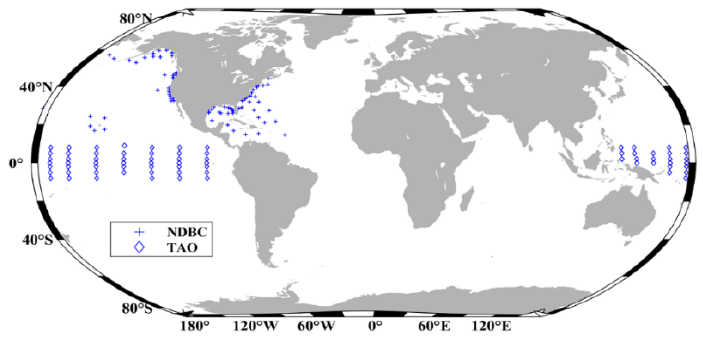
Figure 1. The locations of NDBC and TAO buoys. Buoy-measured wind speeds at different heights above the ocean surface are adjusted to the equivalent neutral winds at 10 m height, utilizing a simple logarithmic wind profile equation [19] where z 0 is the sea surface roughness length, with a constant value of 1.52 × 10 − 4 m assuming a drag coefficient of 1.3 × 10 − 3 [20], z is the reference height of 10 m, z H is the height of anemometer aboard the buoy, and W ( z H ) is the buoy-observed wind speed at height z H